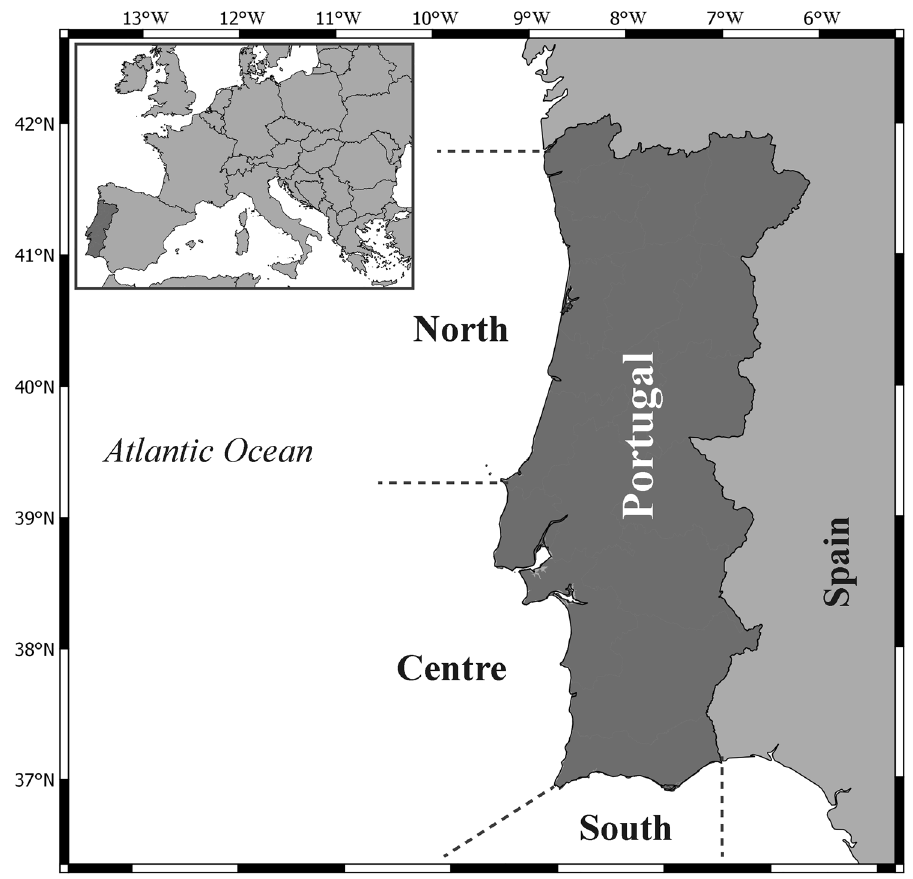
Figure 1. Map of Portugal showing the study area. Horizontal dashed lines delimitate the North, Centre and South area considered in this study. The map was created using QGIS 3.6.3 (http:// qgis.